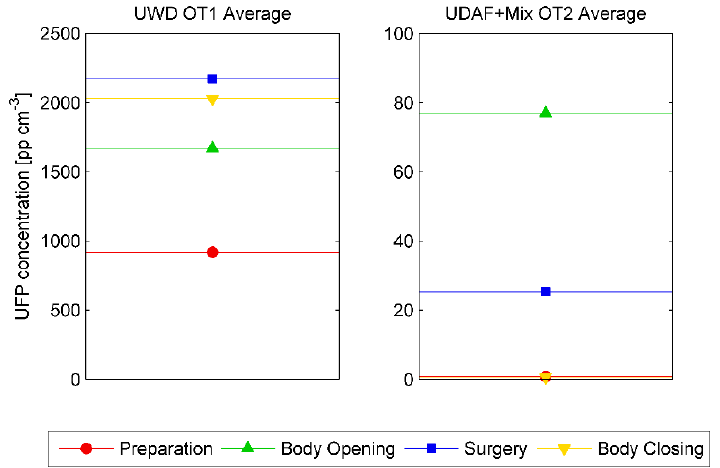
Figure 2. Time average UFPs concentration for UWD OT1 (left) and Hybrid OT2 (right) in all surgeries as function of surgery phases.